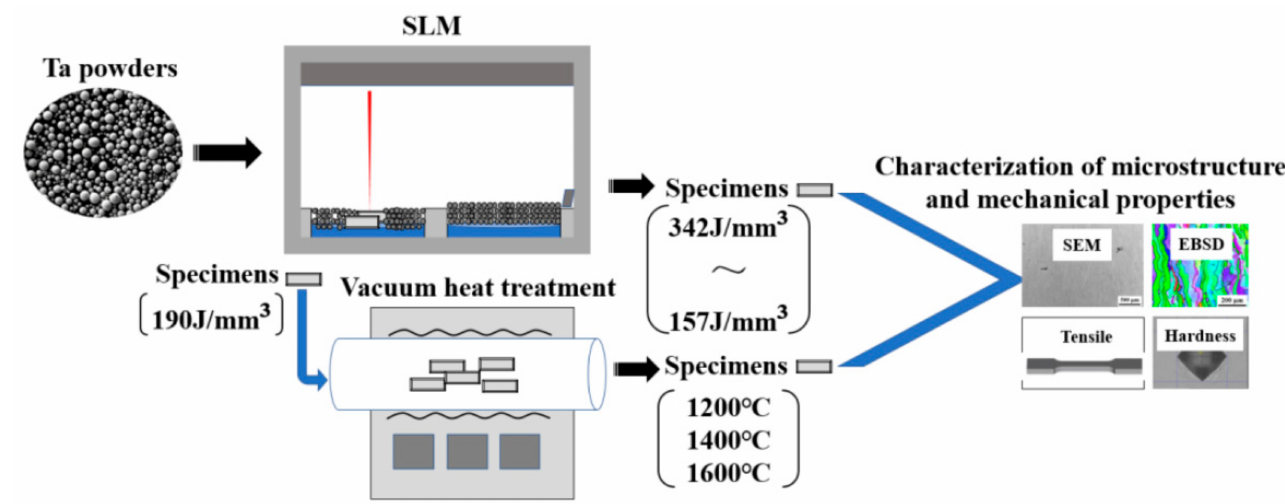
Figure 3. Schematic illustration of the investigation